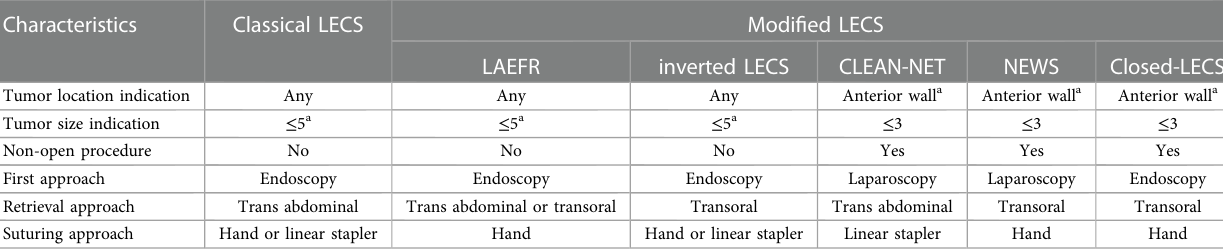
TABLE 17 Overview and comparison of integrated LECS techniques.